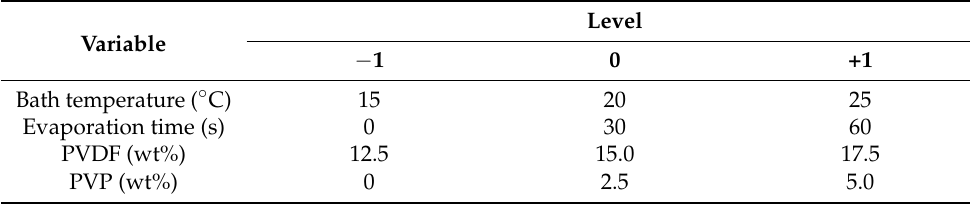
Table 1. Independent variable values for the central composite design of the neat